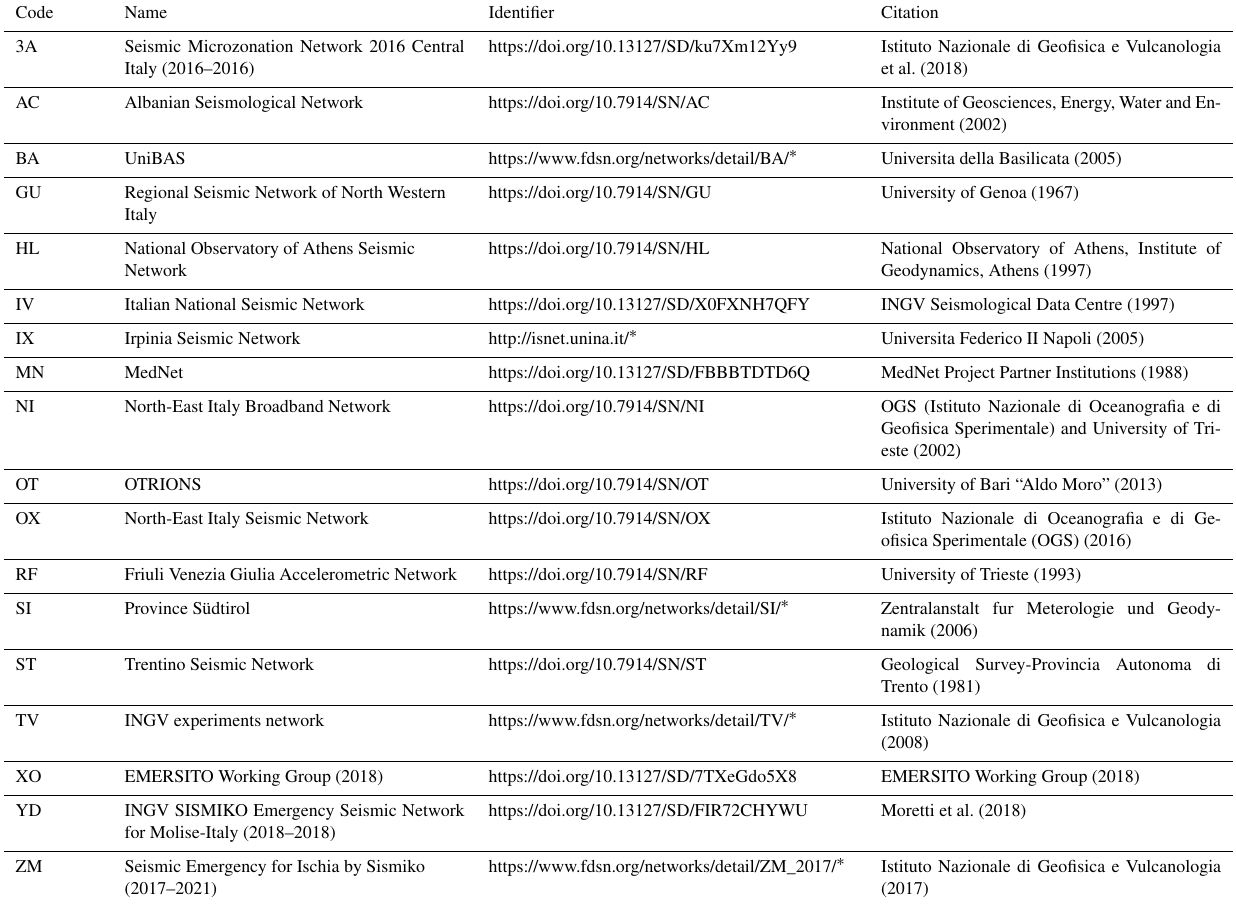
Table 7. Seismic networks used in the compilation of the INSTANCE